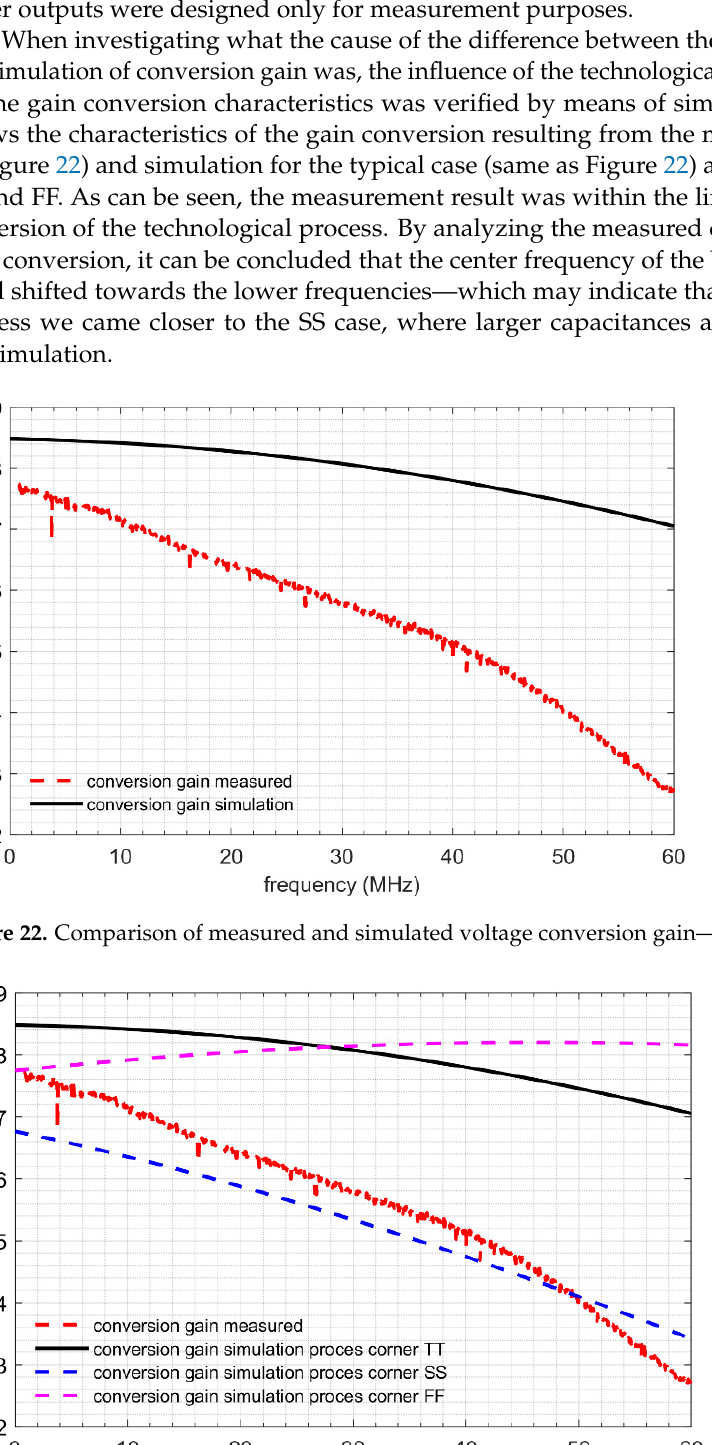
Figure 23. Comparison of the measured voltage conversion gain and the voltage conversion gain simulated with process corners—balun and mixer.